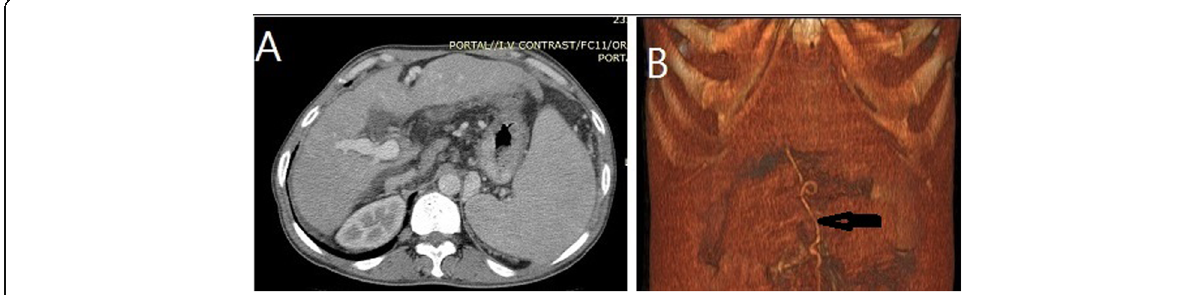
Fig. 1 a , b A 55-year-old male patient. a Triphasic CT study of the liver with CT portography axial image showing recanalized paraumblical vein. b Triphasic CT study of the liver with CT portography 3D image showing recanlized paraumblical vein with abdominal wall collaterals (black